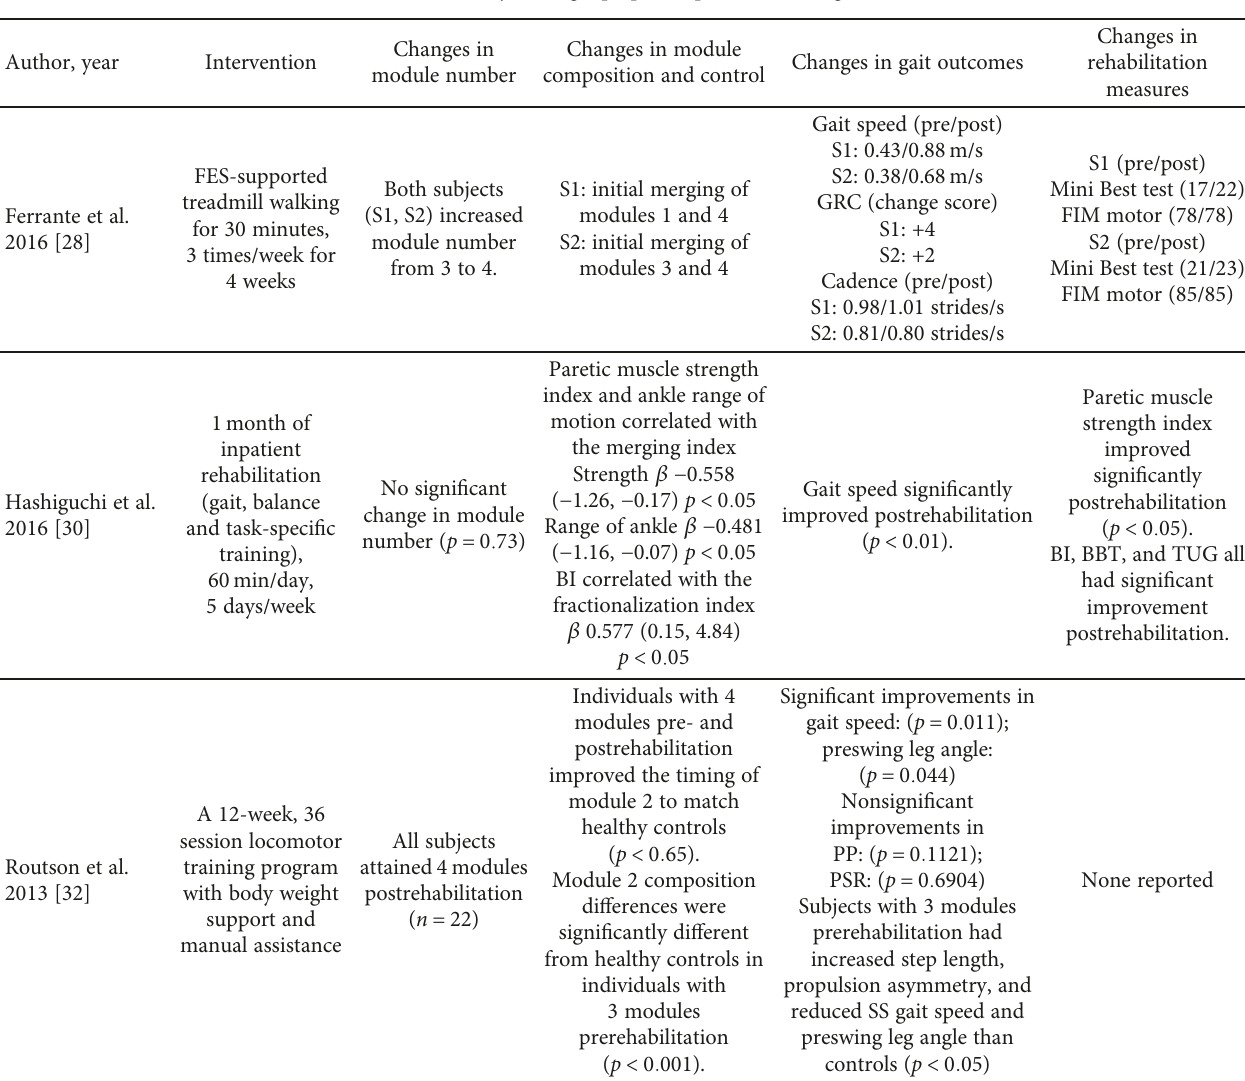
Table 4: Study fi ndings (prepost experimental